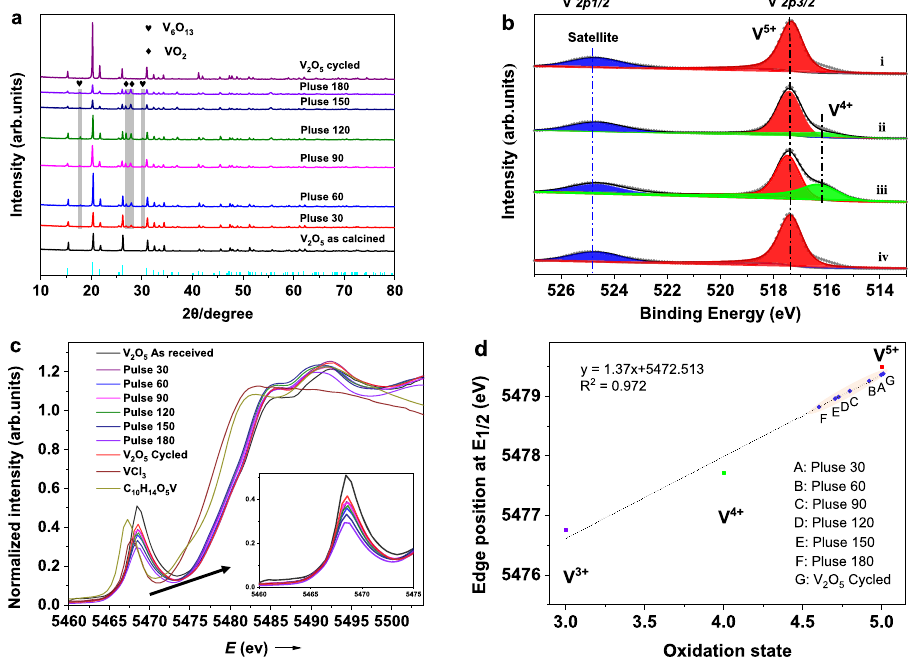
Fig. 3 Structural analyses of V 2 O 5 redox catalyst. a X-ray powder diffraction patterns of V 2 O 5 as a function of NH 3 pulses numbers. The following compounds were identi fi ed: V 6 O 13 (black heart), VO 2 (black diamond), and V 2 O 5 (vertical cyan line). b V 2p XPS spectra of V 2 O 5 sample: (i) as calcined, (ii) after 30 pulses of NH 3 reduction, (iii) after 120 pulses of NH 3 reduction, and (iv) after CLAO redox cycling at 650 °C. c Normalized V K-edge XANES spectra of V 2 O 5 catalysts with different NH 3 pulse numbers together with the standard compounds in different oxidation states. The insert shows the enlarged view of the pre-edge peak. d Plot of position of the absorption edge energies where the normalized absorption equals 0.5 (E1/2) vs the vanadium average oxidation